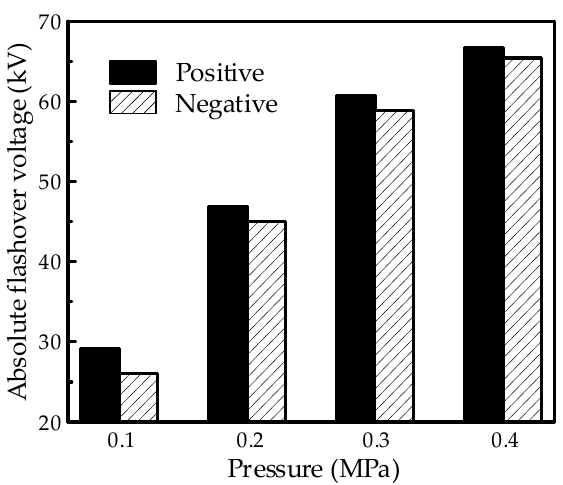
Figure 17. Flashover voltage for finger-type electrodes under different voltage polarities.